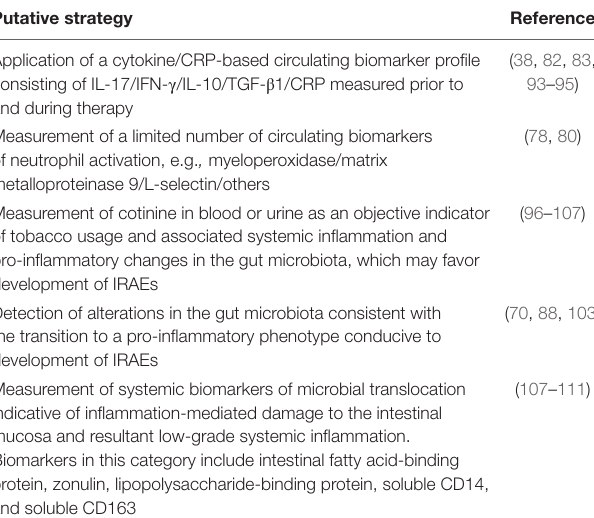
TABLe 4 | Putative strategies to predict of development of immune-related adverse events (IRAEs) during immune checkpoint inhibitor therapy. Putative